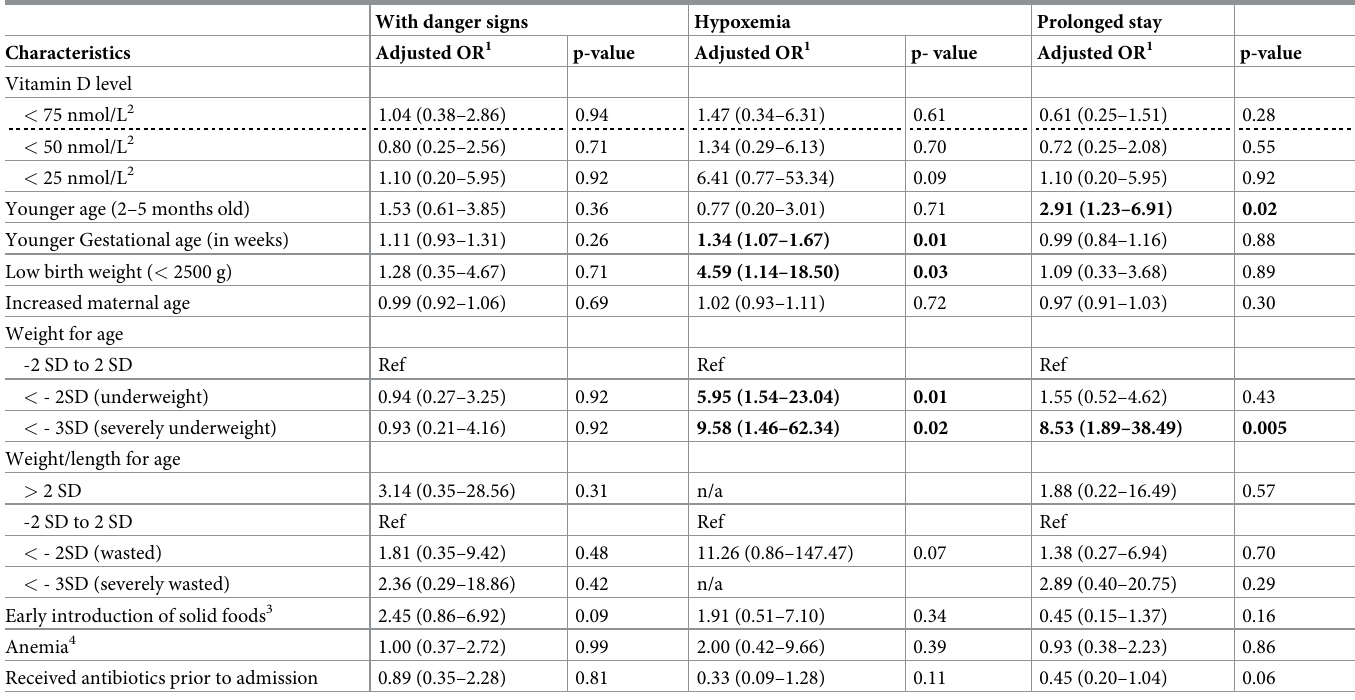
Table 3. Risk factors for severe pneumonia (presence of danger signs, hypoxemia, prolonged